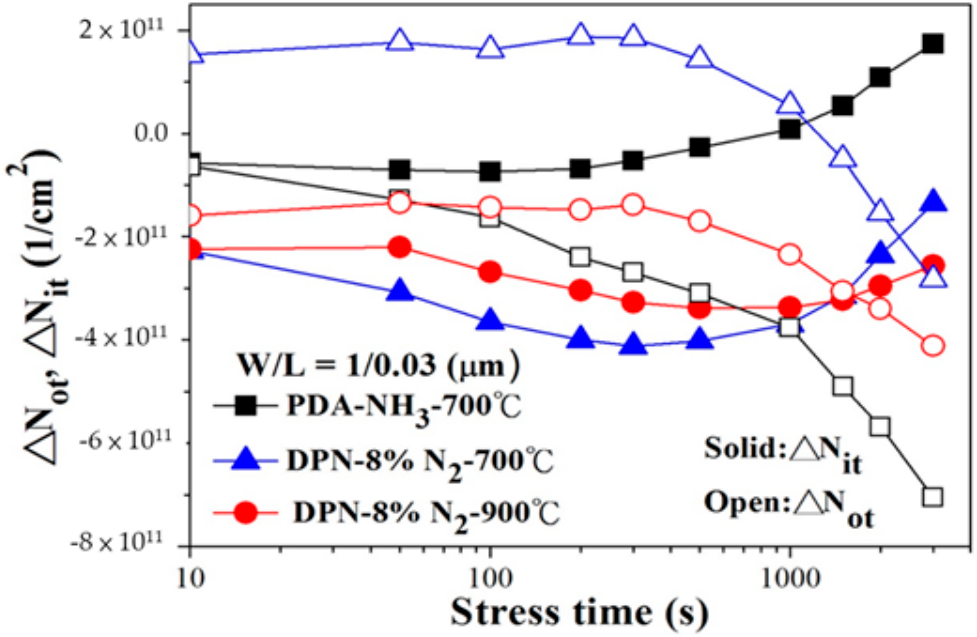
Figure 11. The shift in interface trapped charge and oxide trapped charge after 3000 s CHC stress ( W / L = 1 / 0.03 µ m / µ m) with decoupled plasma nitridation (DPN) or post-deposition annealing (PDA) treatments under 8% N 2 concentration and annealing temperatures.